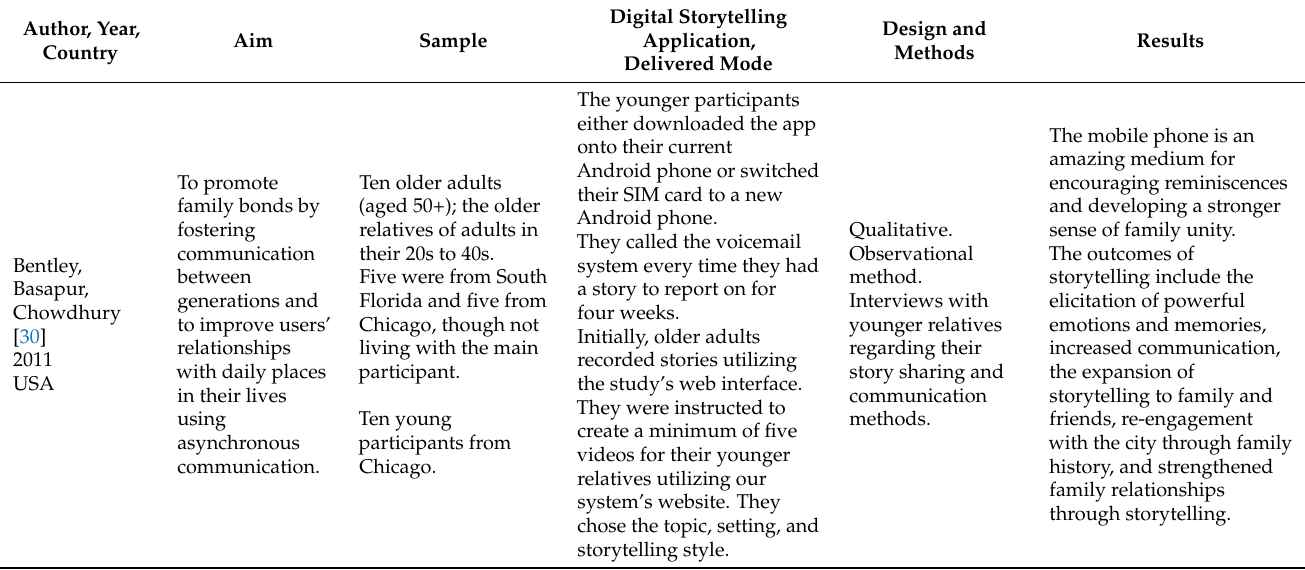
Table A1. Characteristics of the included